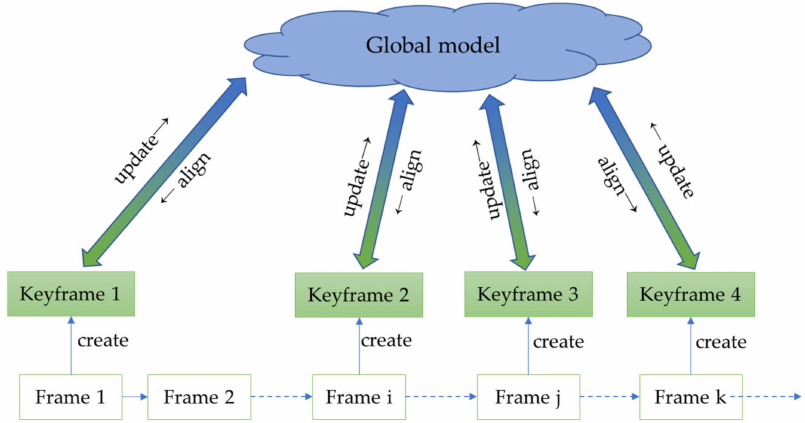
Figure 6. Generation of keyframes and updating the global